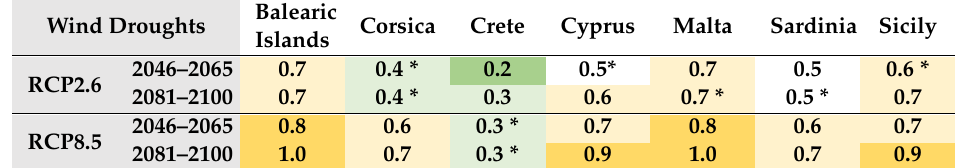
Table 5. Normalized changes (Nc) for wind productivity droughts for each island, scenario and time period. Deep green cells: Nc = 0–0.2; Light green: Nc = 0.3–0.4; White: Nc = 0.5; Light yellow: Nc = 0.6–0.7; Deep yellow: Nc = 0.8–1. Nc and Nu are computed over land. The * indicates the cases in which Nu > 0.5.